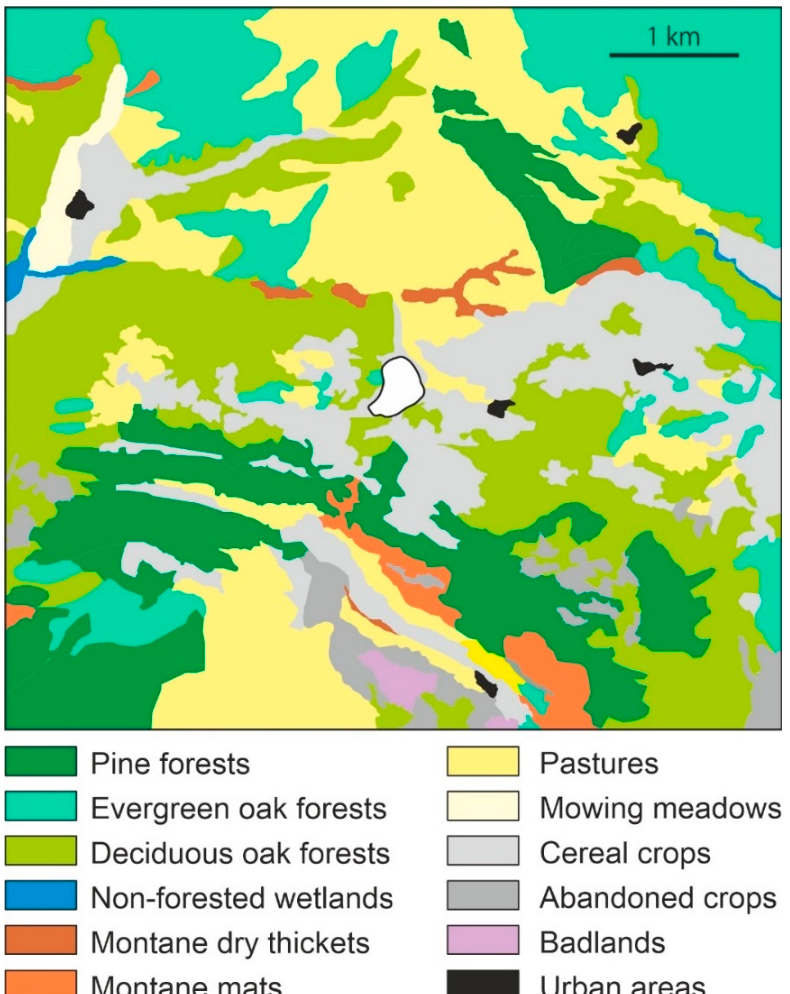
Figure 3. Vegetation map of the Lake Montcortès (white central spot) area showing the typical mosaic arrangement. Forests are represented in green tones for easier visualization. Modified from [51].